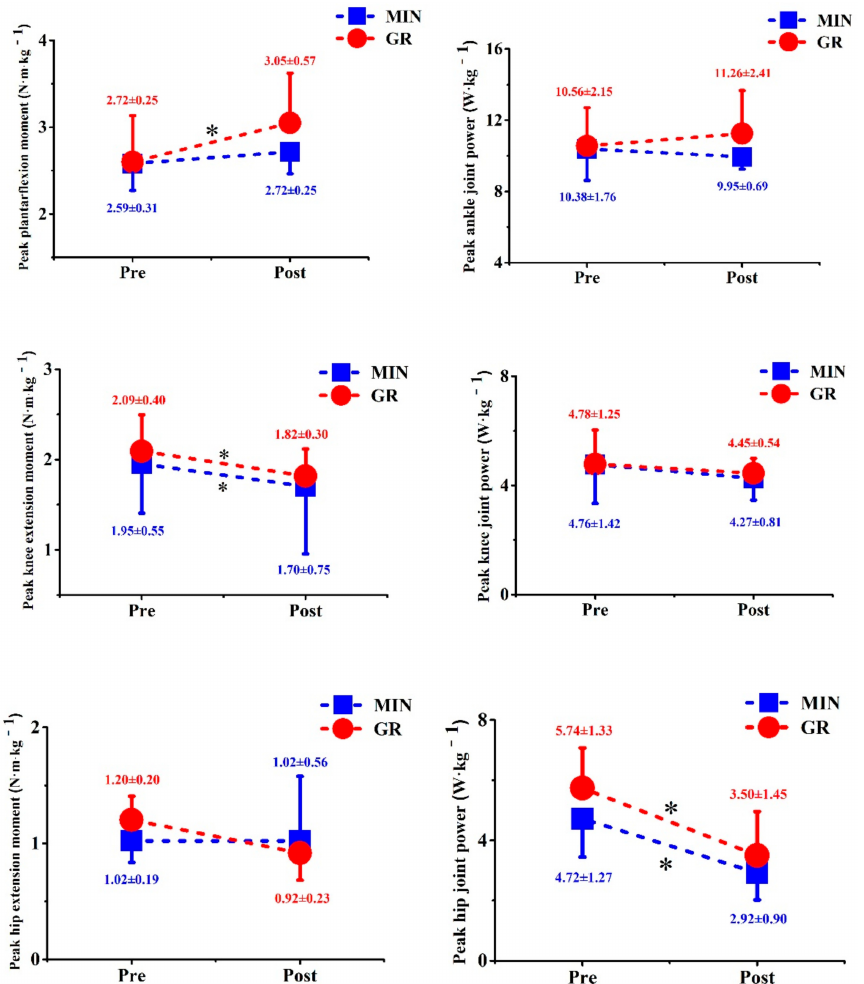
Figure 6. Comparison of peak moment (left column) and peak power (right column) of hip, knee, and ankle between two groups before and after training. * significant di ff erence from pre- to